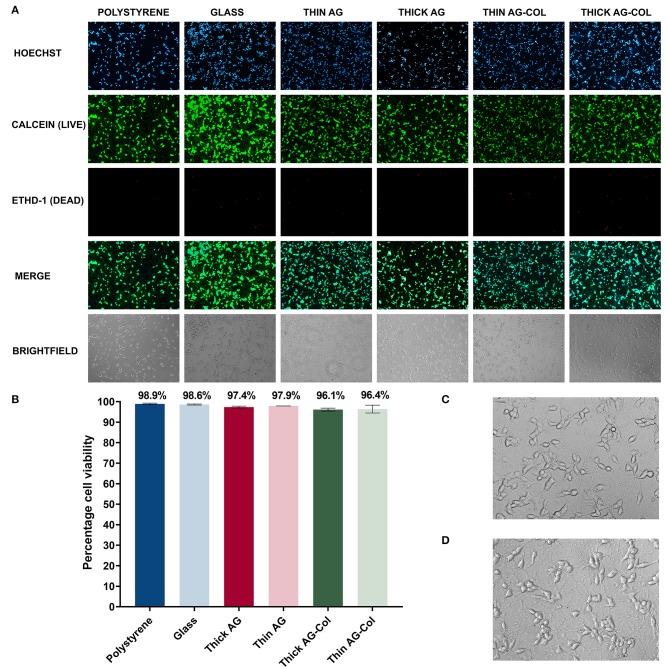
The biocompatibility of the gradient-generator and hydrogels used was investigated using a LIVE/DEAD® viability/cytotoxicity assay on SH-SY5Y neurons after 96 h in culture. (A) LIVE/DEAD® assay fluorescence and brightfield images visualized using a 10× objective. (B) The viability of the neurons was calculated by determining the number of live cells (dual labeled with Hoechst nuclear stain and calcein) as a percentage of the total number of cells. Cells grown on polystyrene and glass were used as the positive control. Each bar represents the mean (two separate regions, three independent replicates n = 6) ± SD. (C) Morphology of neurons cultured on Matrigel-coated polystyrene (20× objective). (D) Morphology of neurons cultured on the Matrigel-coated gradient-generator overlaid with thin agarose hydrogel (20× objective).